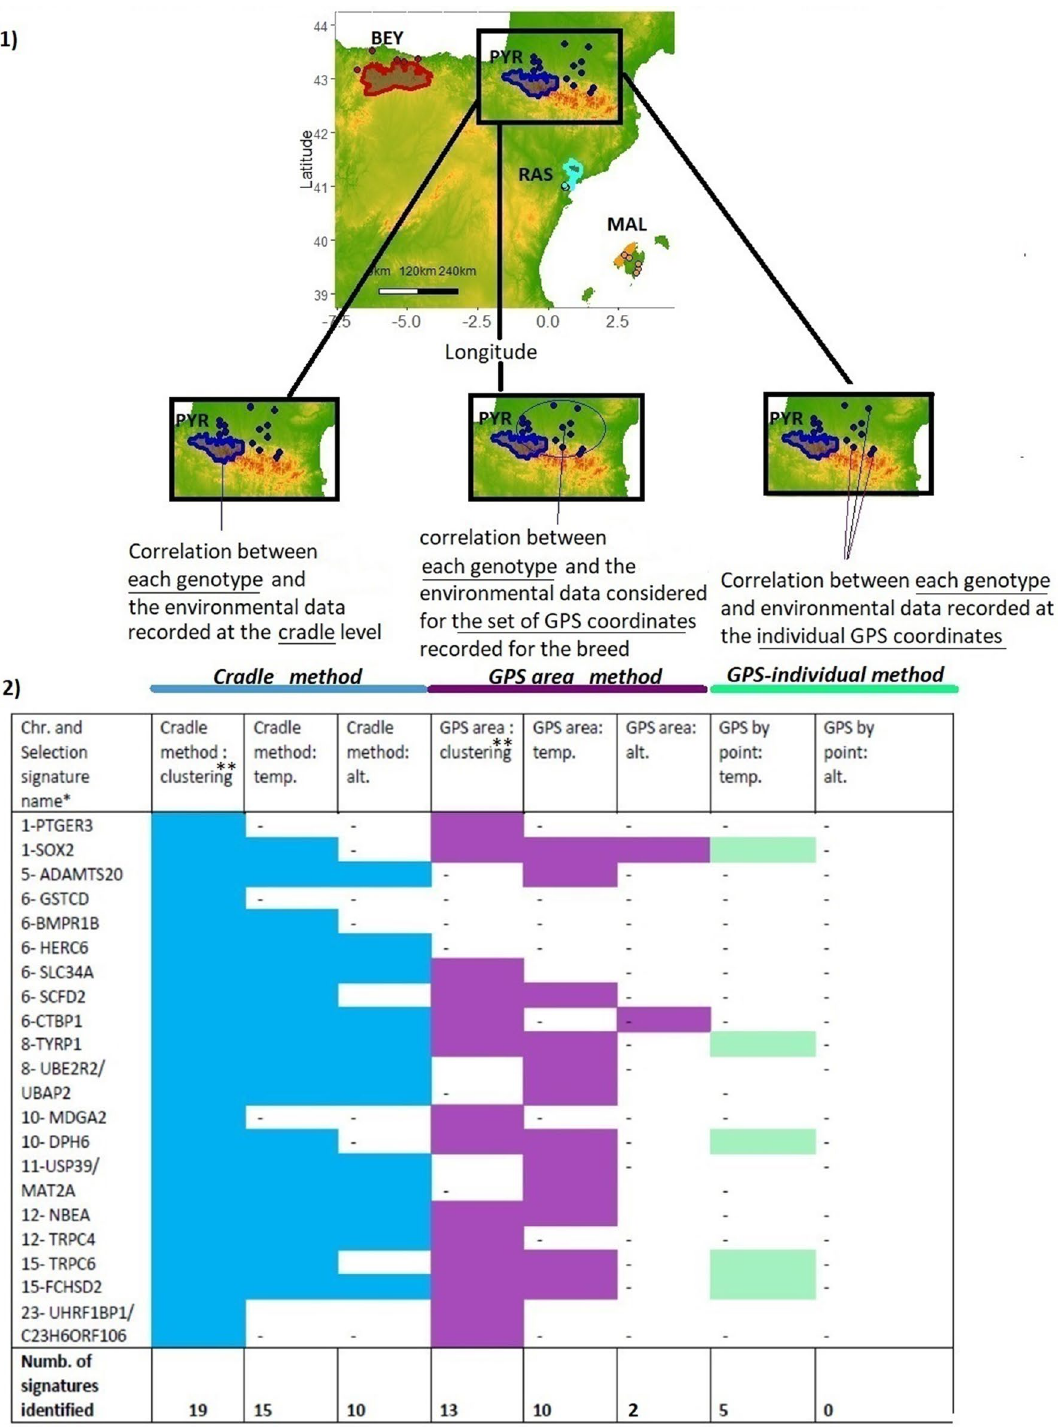
Figure 3. Experimental test of the method. The signature search was done via LFMM. The environment was characterized either at the level of the GPS coordinates (individual GPS method) or considering all the GPS points recorded for a given breed (GPS area method), or at the level of the cradle (cradle method). The environmental variables Altitude and Mean Annual Temperature were considered individually. Chr.: chromosome number. *Selection signature are named according to the gene(s) most likely targeted by the selection process, taking into account the distance of the SNPs from the genes, the associated p values and the number of SNPs near or in the gene(s); it is possible to know in detail the genes associated with each selection signature (see Supplementary Table 3). **Clustering: the environment was characterized considering all the variables at the same time and according to the PCA/HCPC